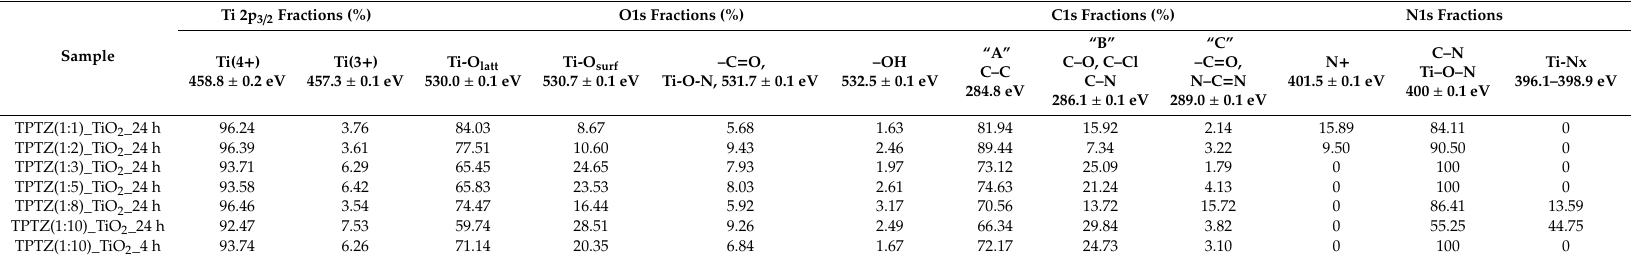
Table 4. Chemical characteristics of titanium, oxygen, carbon, and nitrogen states in the surface layer of [TPTZ][Cl] IL-modified TiO 2 particles, evaluated by XPS